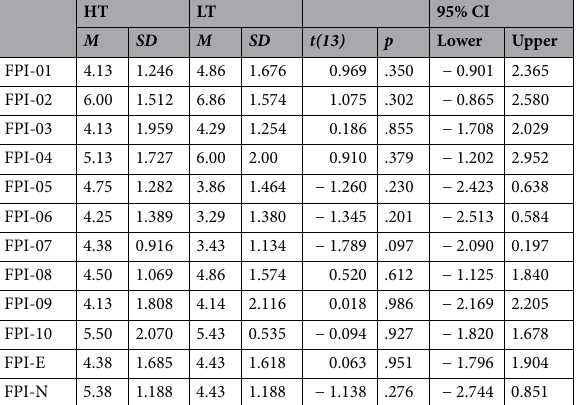
Table 1. Hypothesis 1: comparisons of the FPI-R subscales between high and low self-touching individuals. Results of independent samples t-test. FPI-R, Freiburg personality inventory; HT, high self-touching individuals; LT, low self-touching individuals; CI, confidence interval.